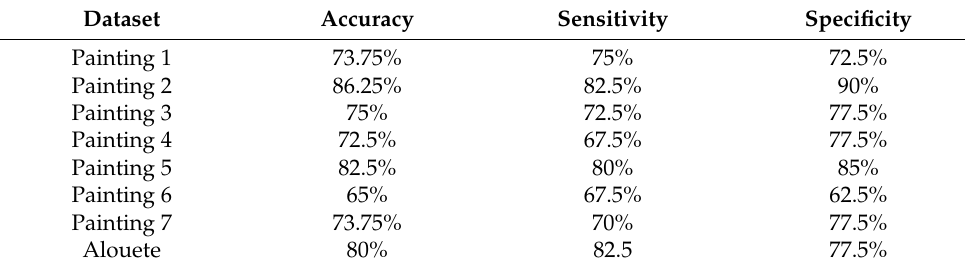
Table A1. Support vector machine scores for AIDEAL based data sets.